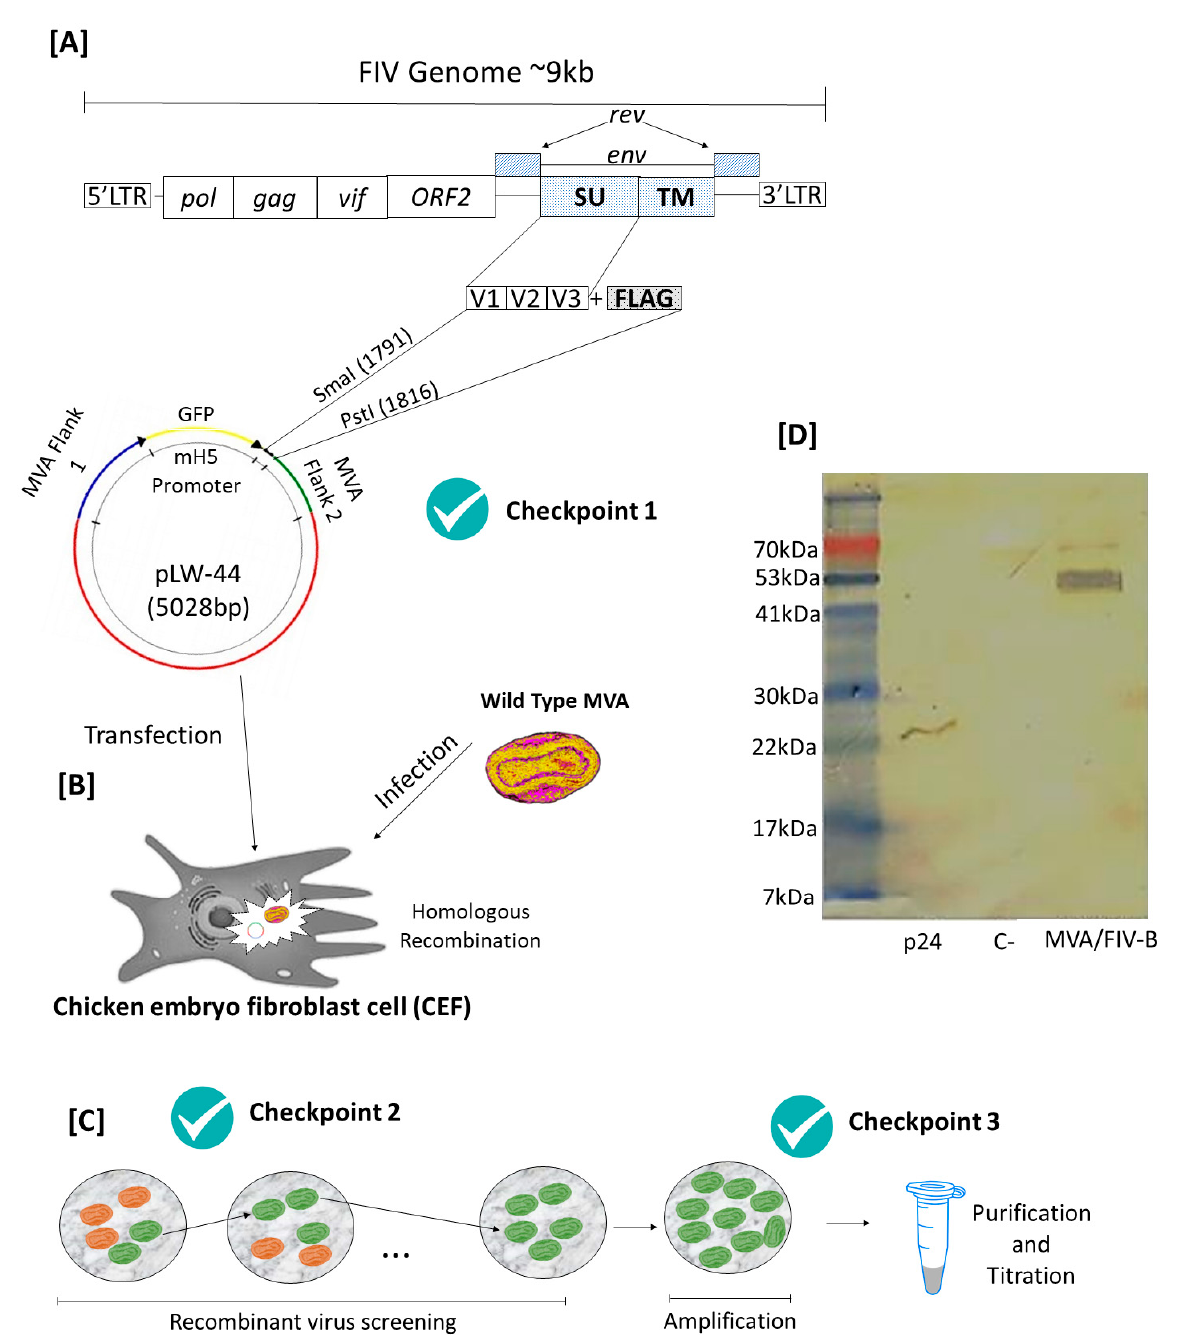
Figure 1. The construction process of the recombinant virus MVA/FIV-B. ( A ) Obtaining the V1–V3 sequence and inserting the FLAG portion and restriction sites for further cloning in plasmid pW-44. ( B ) Homologous recombination in the chicken embryo cell (CEF) by transfection with plasmid pLW-44/FIV-V1–V3 and infection with wild MVA. ( C ) Selection process of recombinant clones, followed by amplification, purification and titration. ( D ) Western blot using FIV + cat sera as pool. P24 represents the viral capsid protein used to diagnose FIV. MVA/FIV represents the total protein extraction of BHK-21 cells infected with MVA/FIV-B, and C - represents total proteins extracted from uninfected BHk-21